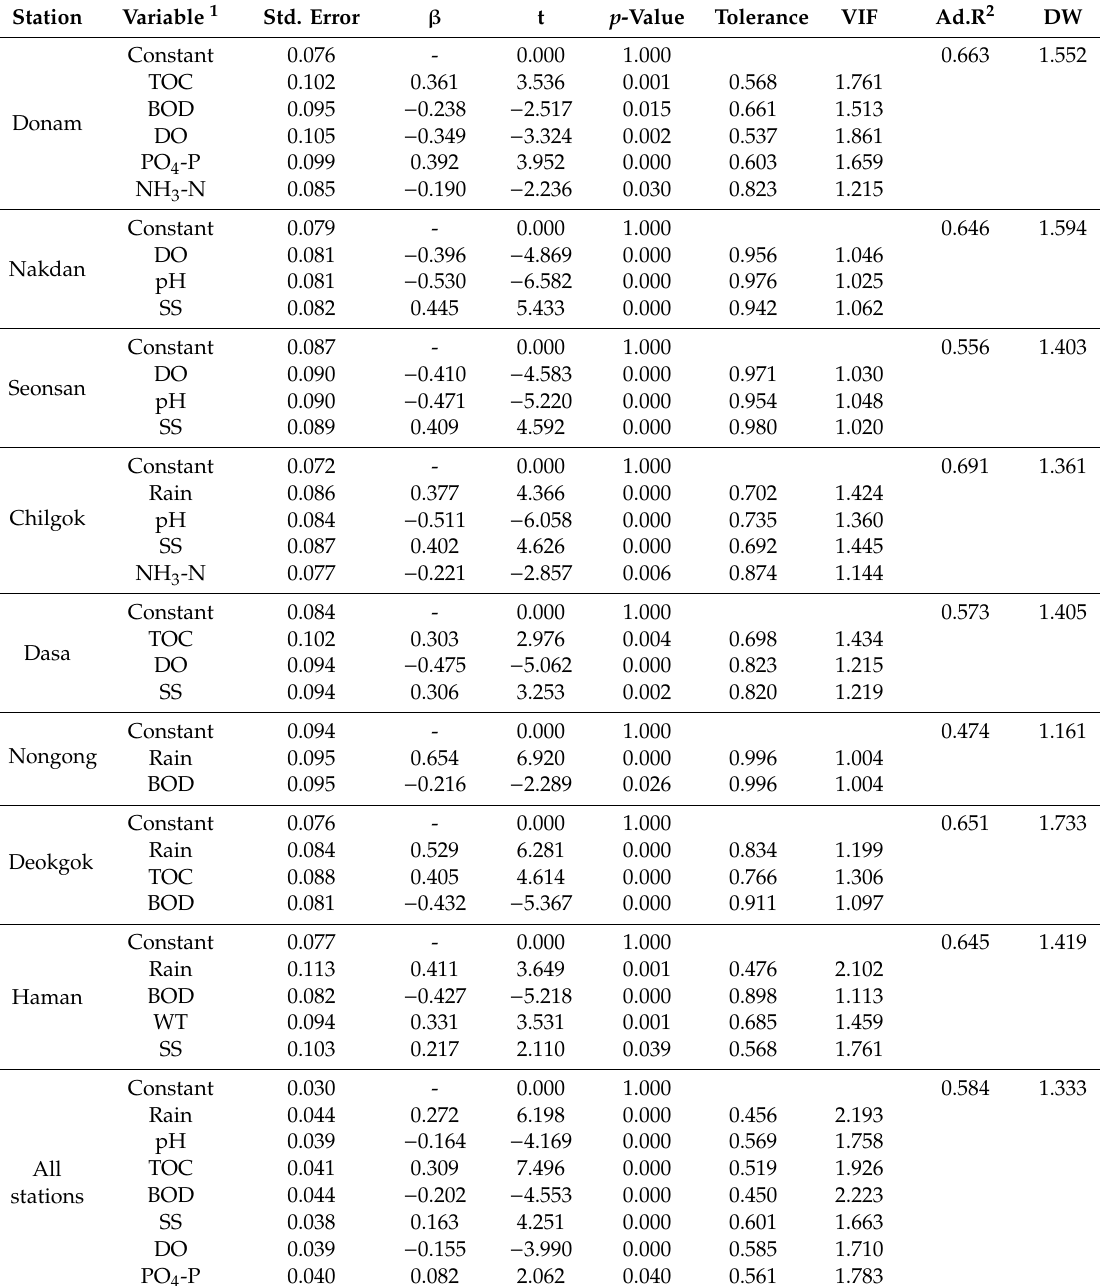
Table A1. Multiple regression results between total coliforms and water quality factors at each weir